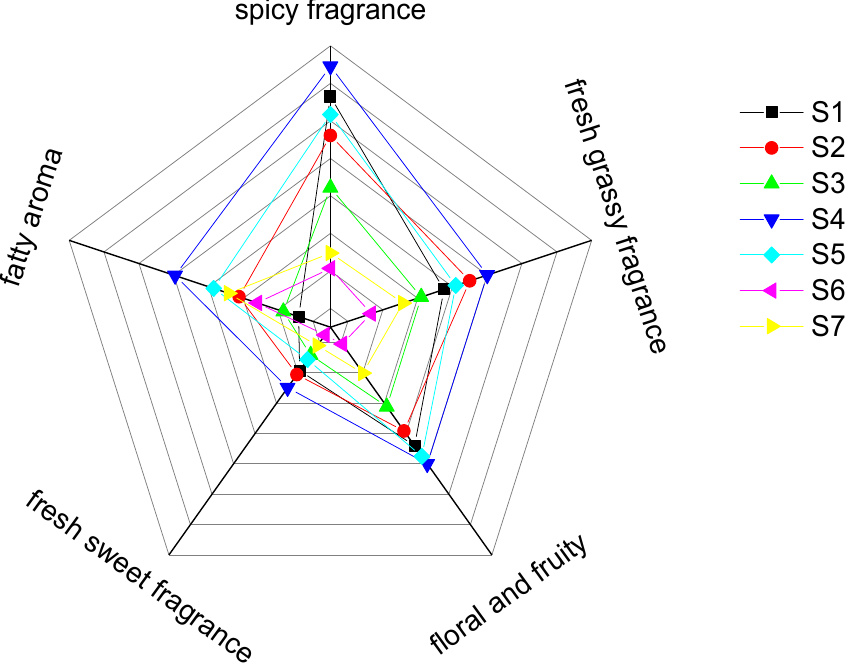
Figure 3. A comparison chart of flavor evaluation of the different varieties of pepper oil.